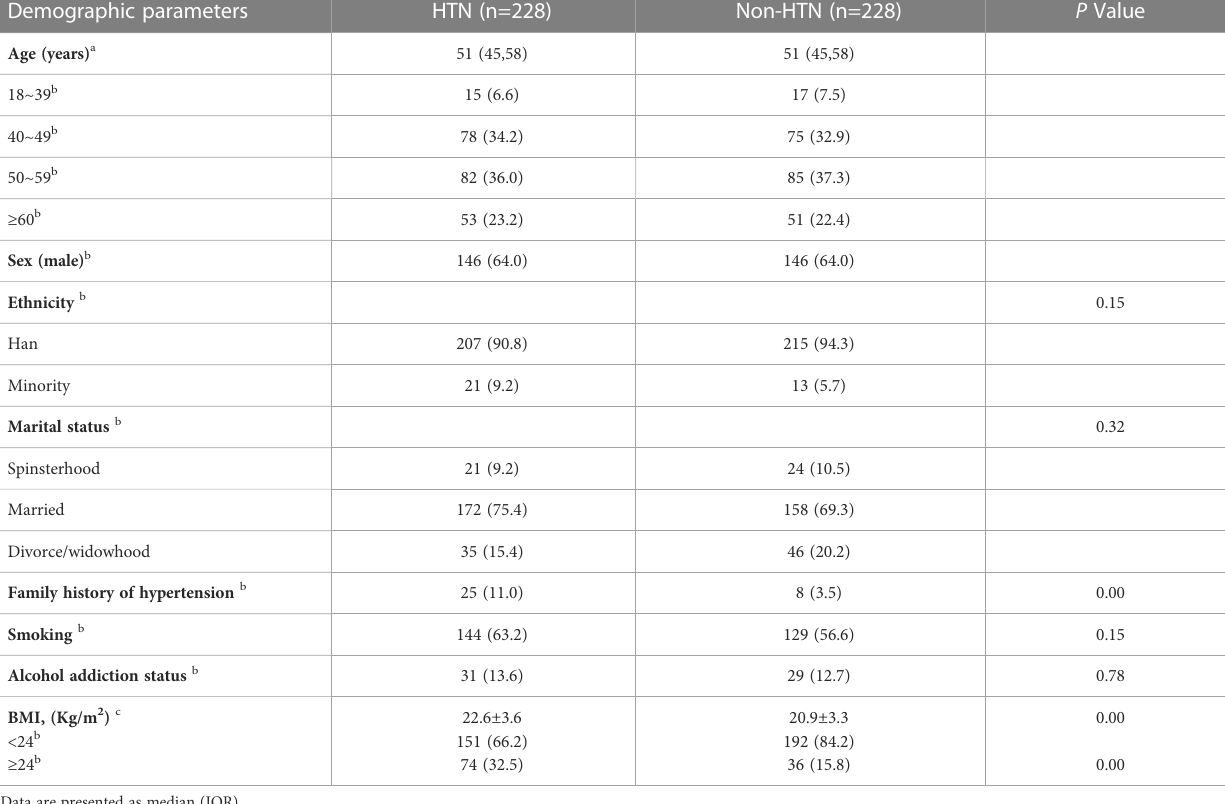
TABLE 1 Demographic parameters of Patients in Both Groups.